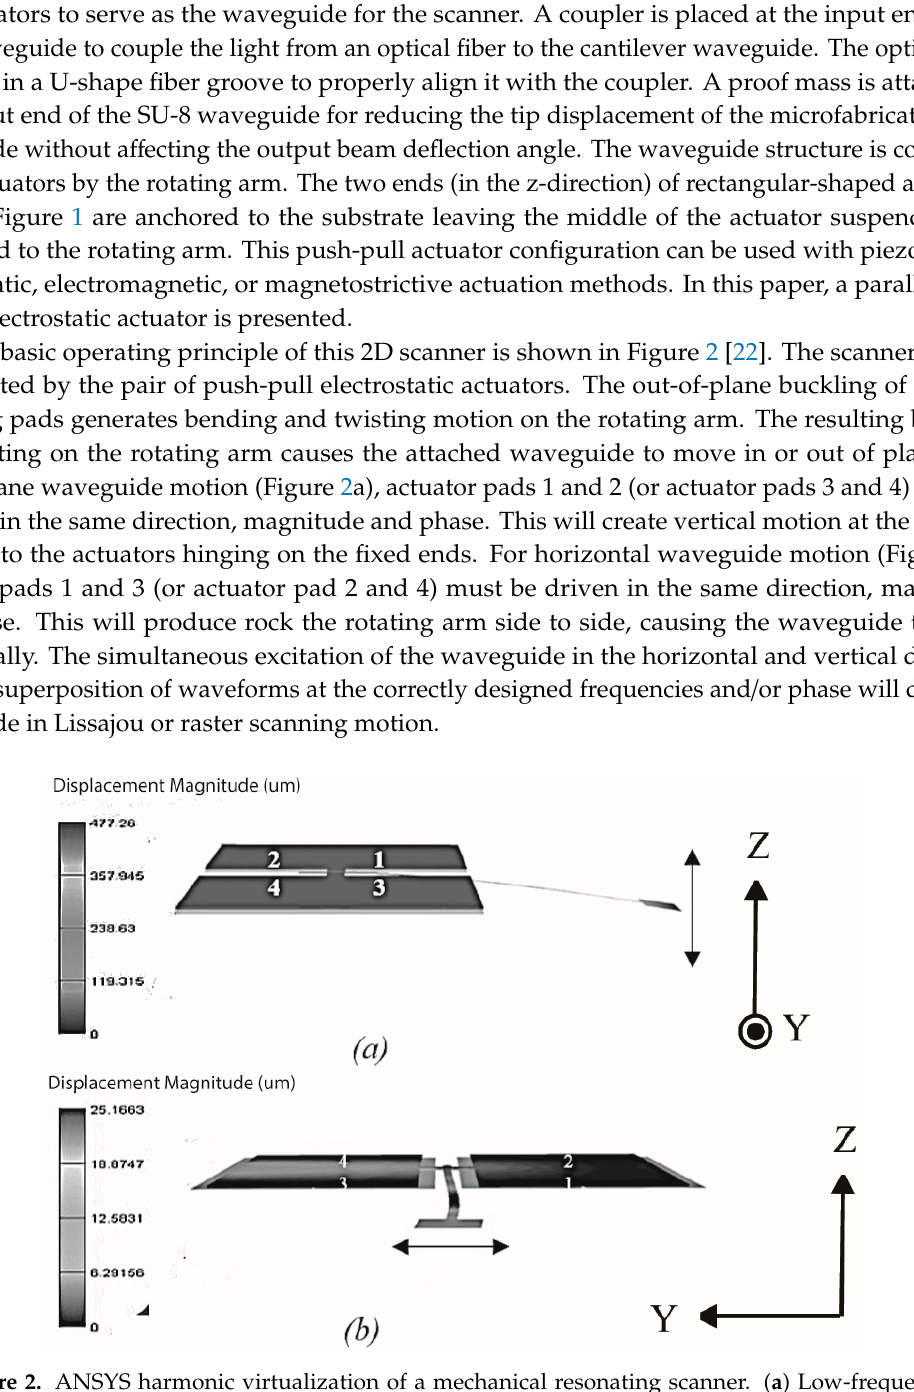
Figure 2. ANSYS harmonic virtualization of a mechanical resonating scanner. ( a ) Low ‐ frequency motion under the excitation of the first mode along the z ‐ axis, and ( b ) high ‐ frequency motion under the excitation of the second mode along the the excitation of the second mode along the y ‐ axis.